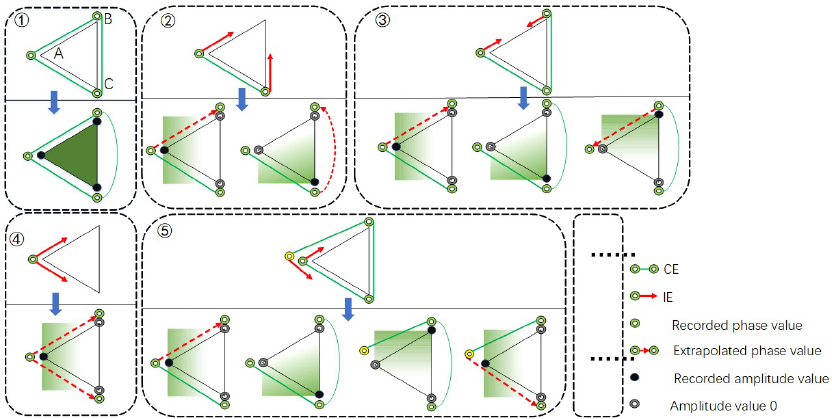
Figure 6. Different edge set input and vertex phase value computing